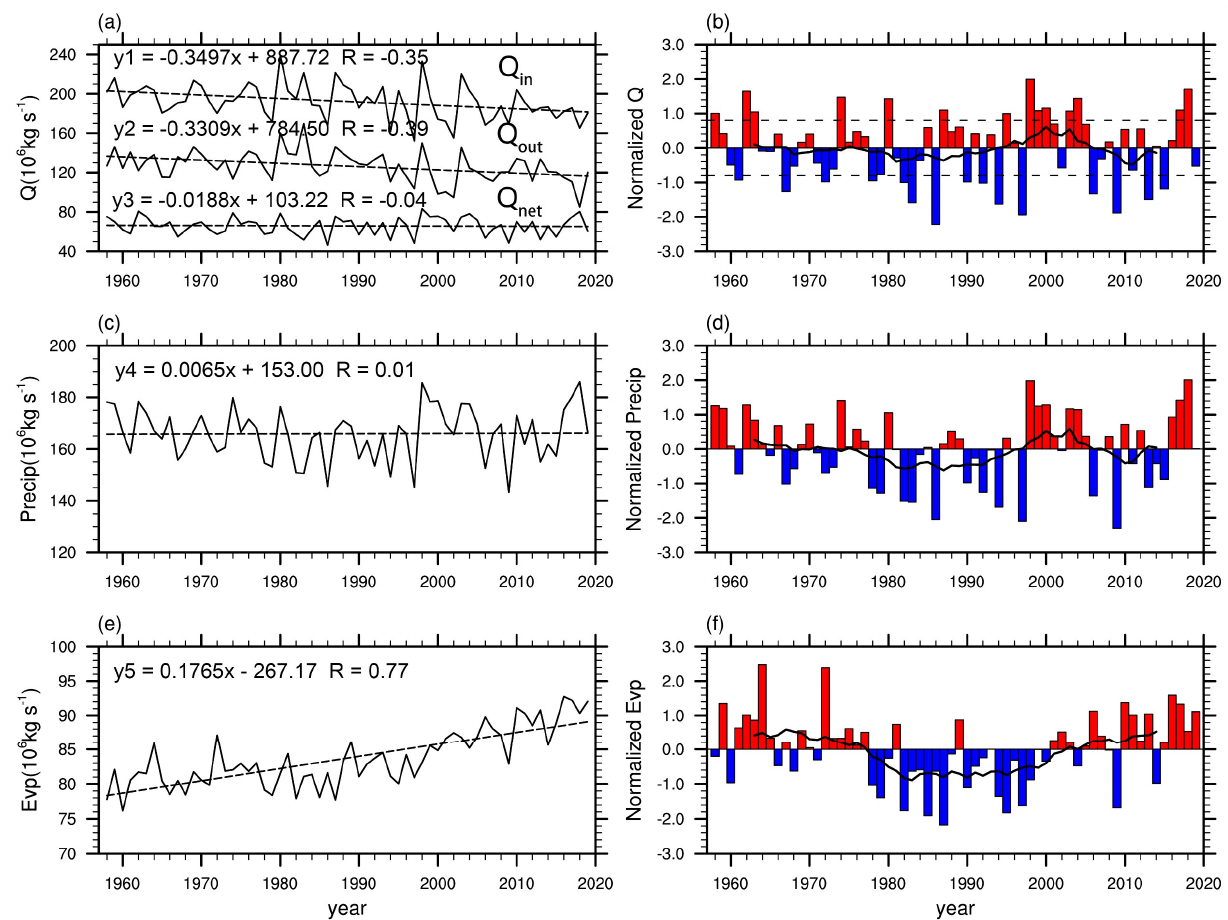
Figure 3. Time series of summer atmospheric water cycle elements on the TP from 1958 to 2019; the left column is the instantaneous value of the climatic state (unit: 10 6 kg s − 1 ); the right column is the detrend standardized time series and the 11 − year moving average. Among them: ( a , b ) the WVB s, ( c , d ) precipitations, ( e , f ) evapotranspirations. The black dashed lines indicate linear trend in ( a , c , e ).